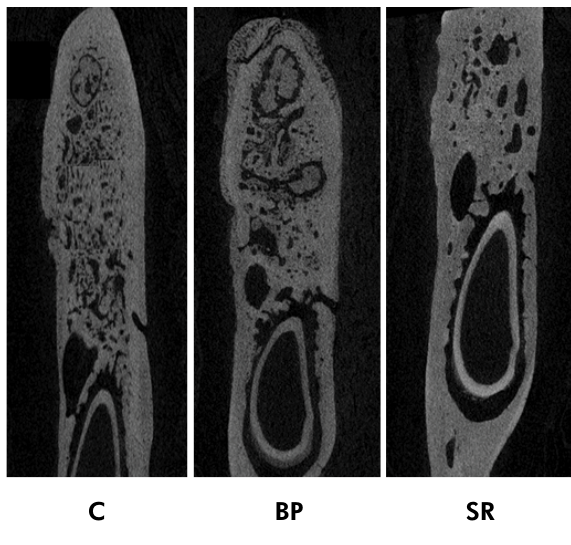
Figure 3. Cross-section from the occlusal direction to the base of the mandible in the control, BP, and SR groups. Observe the presence of bone sequestration in the BP group (white